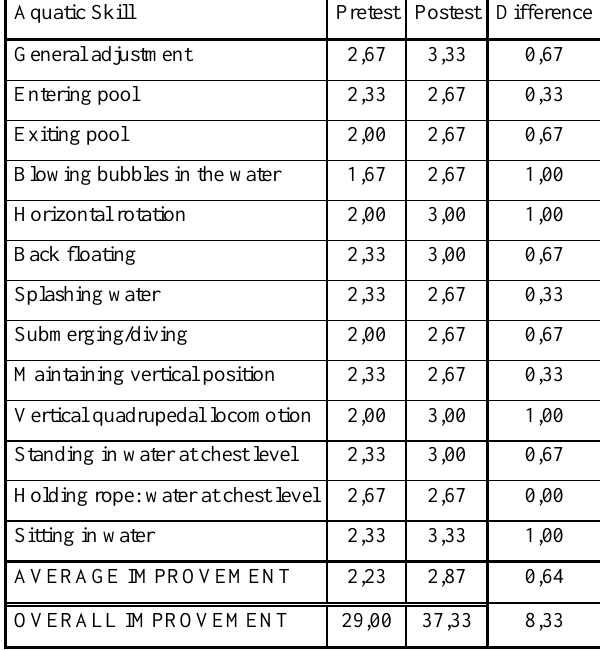
Table 1 Results for Students with Diparetic form of Cerebral Palsy Aquatic